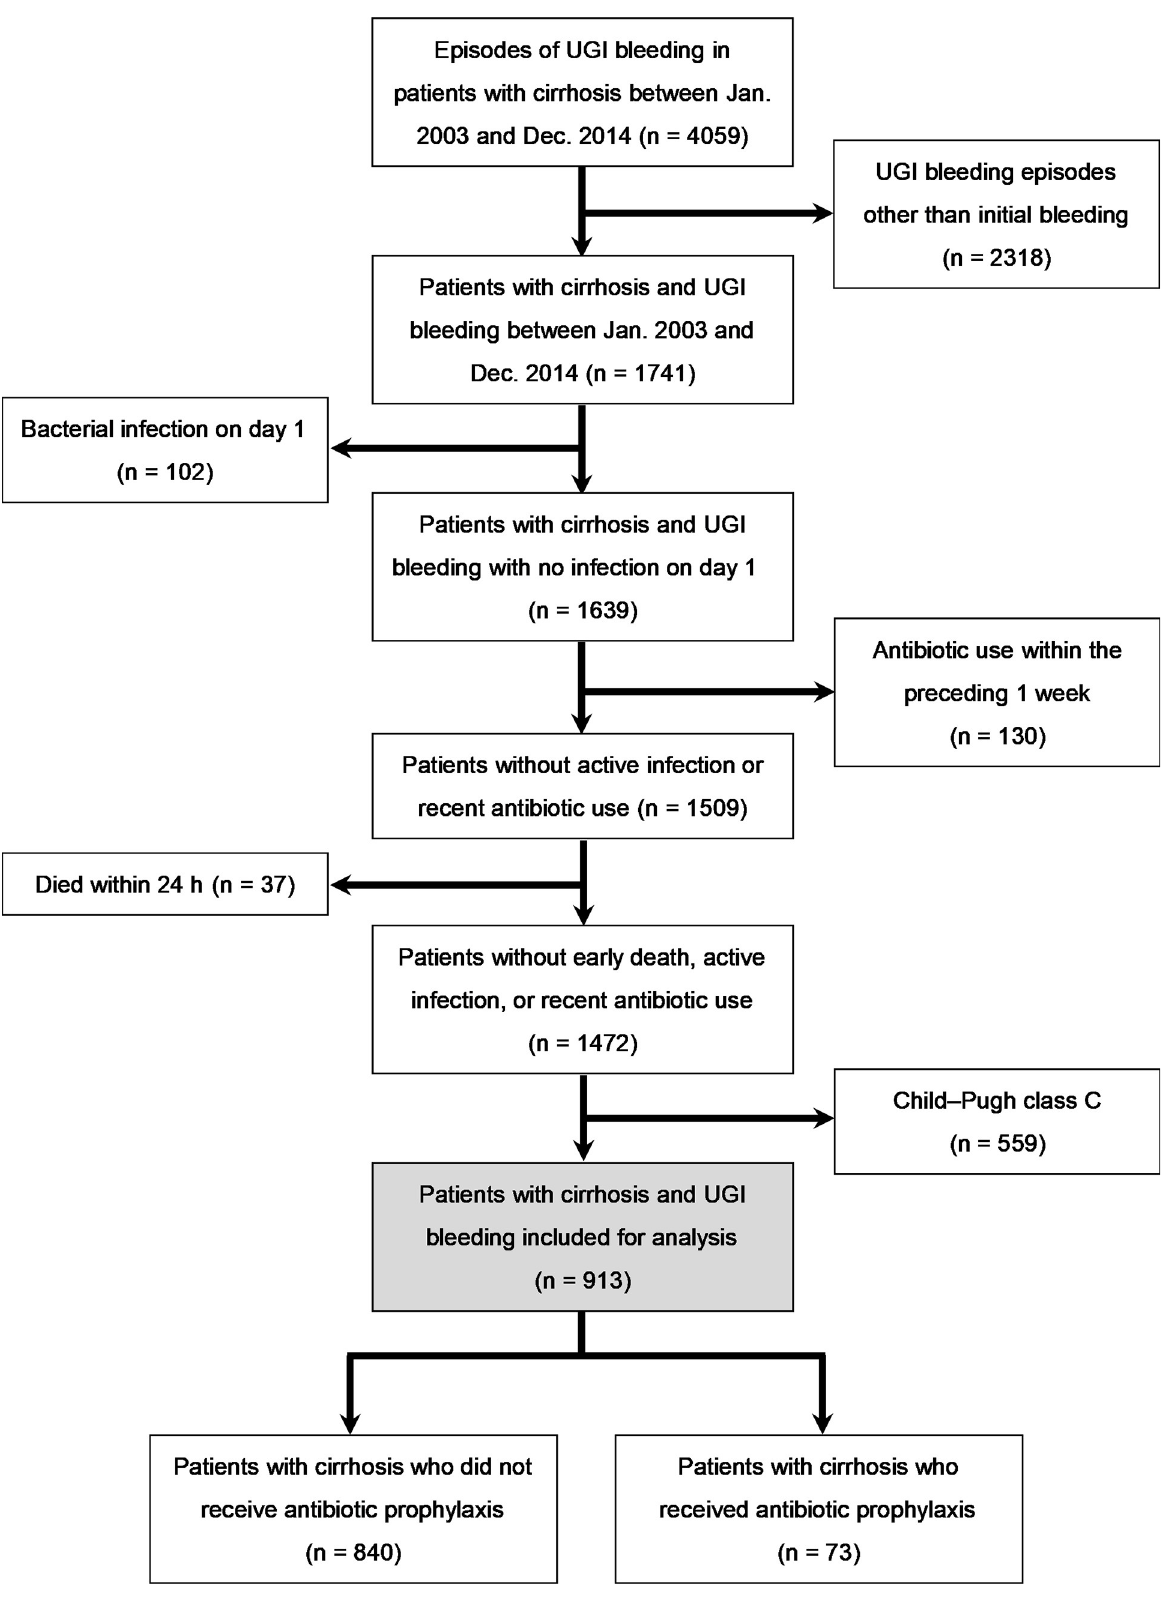
Fig 1. Flow of patient